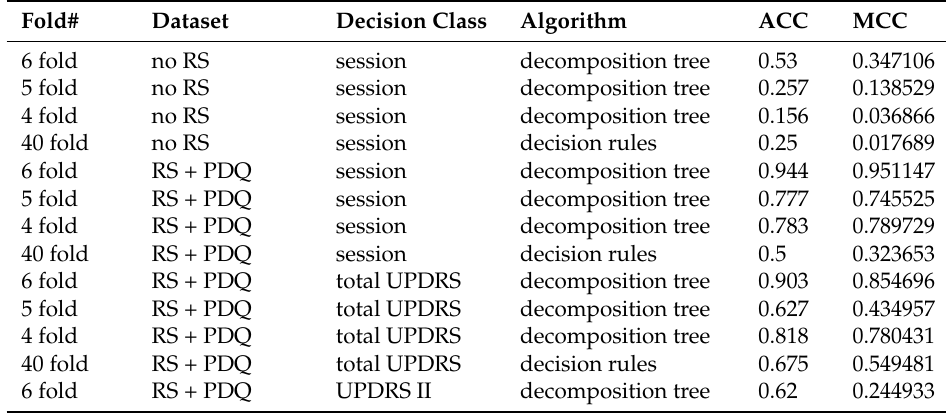
Table C1. Comparison rough set classifiers with different fold number, accuracy (ACC), Matthews correlation coefficient